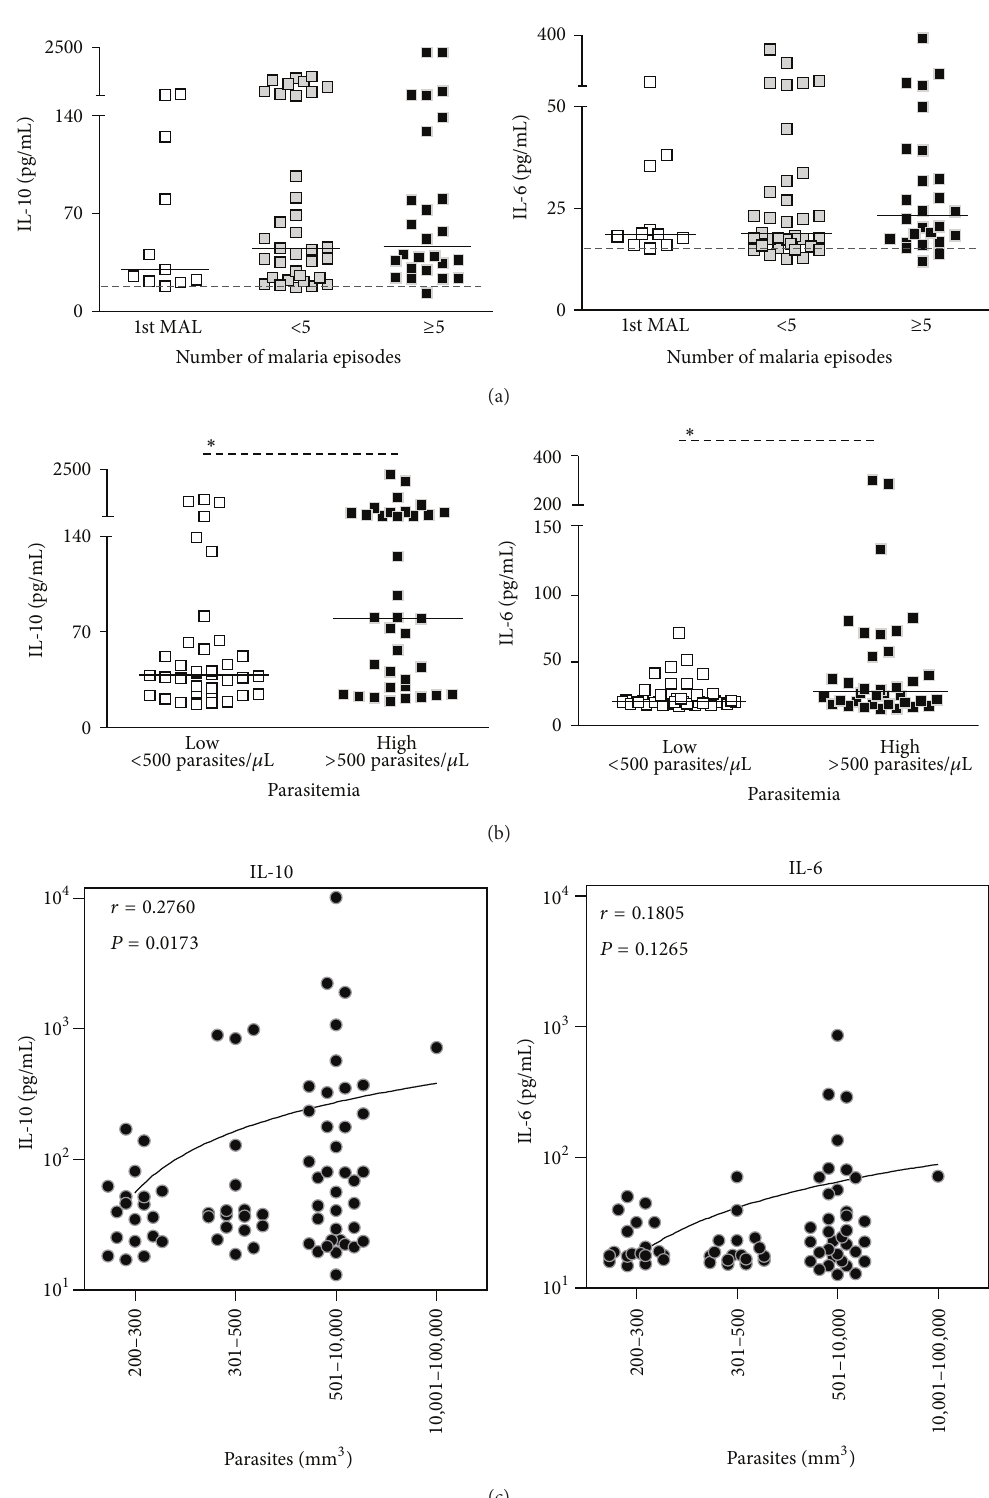
Figure 2: Levels of IL-6 and IL-10 are associated with parasitemia. Levels of IL-6 (figures on the right) and IL-10 (figuress on the left) were measured and analyzed based on the number of malaria episodes (a) and on the parasitemia (b). Correlation between the levels of IL-6 and IL-10 ( 𝑦 -axis) and parasite load ( 𝑥 -axis) (c). Levels of biomarkers were measured employing ELISA or Cytometric Bead Array